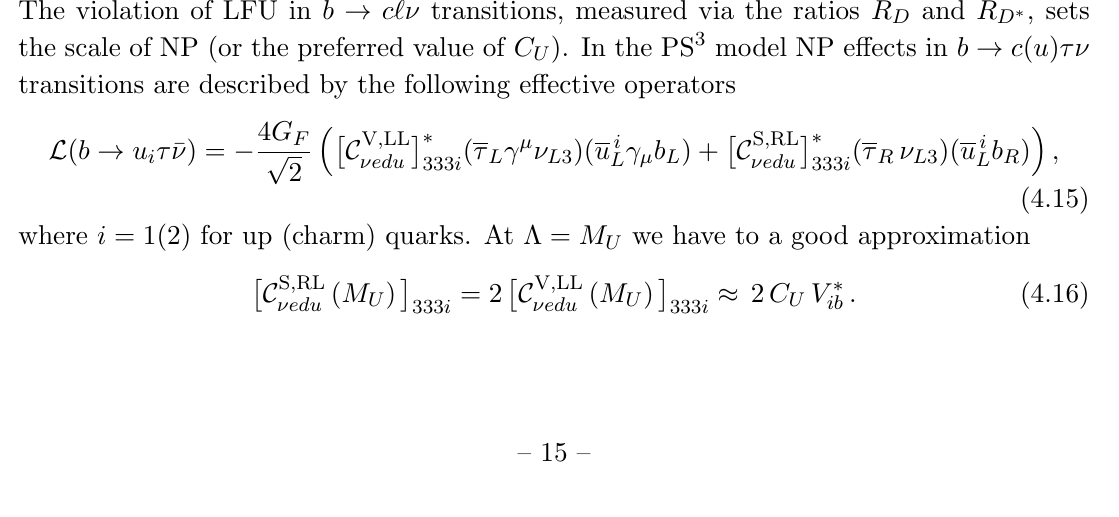
) as function of (cid:30) b 1